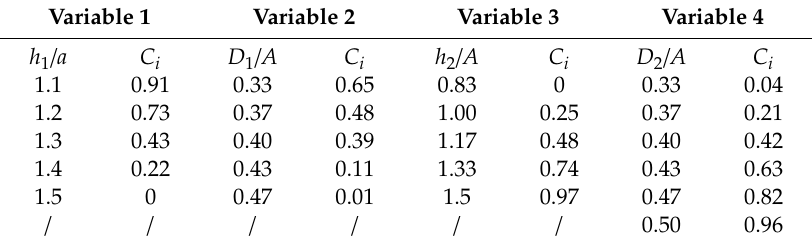
Table 3. Comprehensive performance evaluation of cyclone